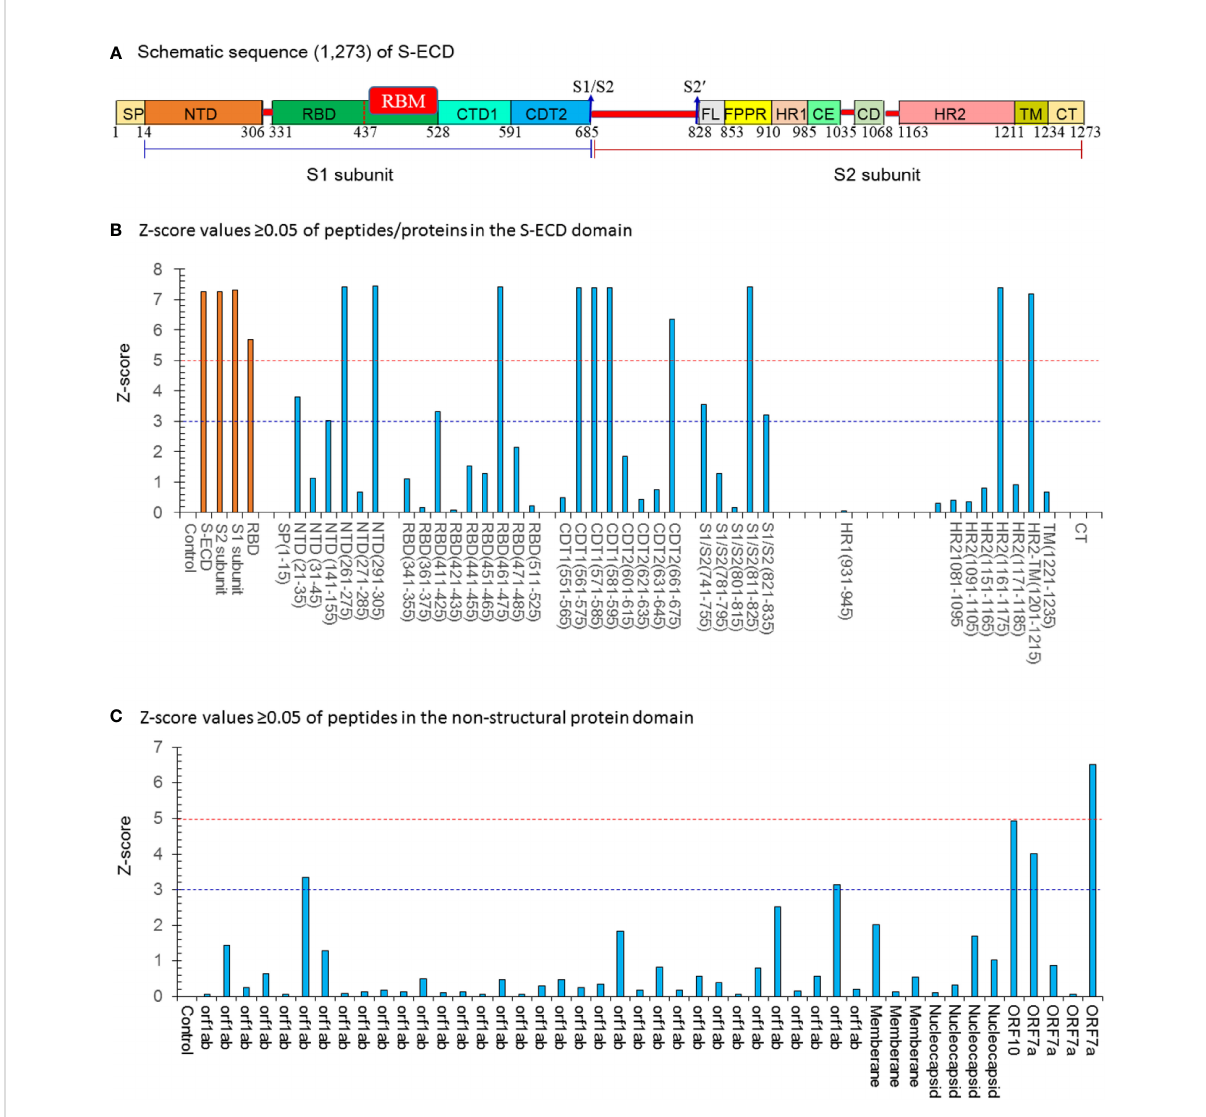
FIGURE 1 The Z-score values ≥ 0.05 of peptides/proteins in the S-ECD domain by the SARS-Cov-2 proteome microarray. (A) Schematic sequence (1,273) of a full-length SARS-CoV-2 spike. Two major domains within the spike protein are denoted as S1 head (S1) and S2 stalk regions (S2). The different domains are shown in different colors: SP (single sequence), NTD (N-terminal domain); RBD (receptor-binding domain) containing the RBM (receptor binding-motif), CTD1 (C-terminal domain 1), CTD2 (C-terminal domain 2), S1/S2 border (S1/S2 cleavage site), S2 ′ (S2 ′ cleavage site), FL (fusion loop), FPPR (fusion peptide proximal region), HR1(heptad repeat 1), CH (central helix region), CD (connector domain), HR2 (heptad repeat 2), TM (transmembrane domain), and CT (cytoplasmic tail). (B) Z-score values ≥ 0.05 of peptides/proteins in the S-ECD domain;15 potent peptides had a Z score ≥ 3.0. (C) Z-score values ≥ 0.05 of peptides/proteins in the non-structural protein domain. Five potent peptides had a Z-score ≥ 3.0. Con.: Control (PBS